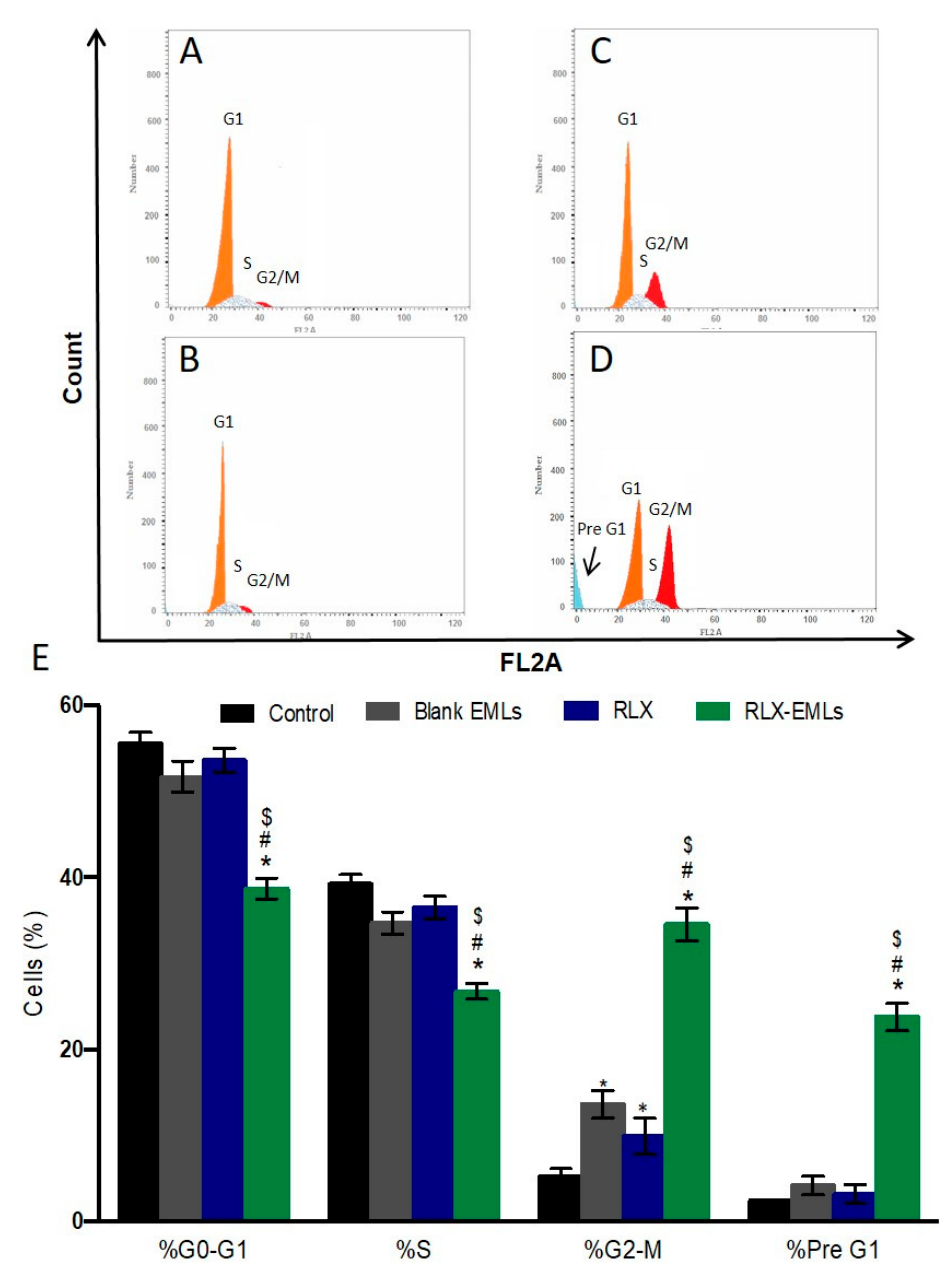
Figure 3. Effect of RLX-EMLs or RLX on MCF-7 cell cycle changes of MCF-7 cells using flow cytometry analysis. The cells were treated with RLX-EMLs or RLX for 48 h. ( A ) control, ( B ) blank EMLs, ( C ) RLX, and ( D ) RLX-EMLs. ( E ) graphical presentation of each phase. All data are presented as the mean ± SE of three independent experiments. * P < 0.0001 considered significantly different from the control. $ P < 0.0001 considered significantly different from RLX, # P < 0.0001 considered significantly different from blank EMLs.